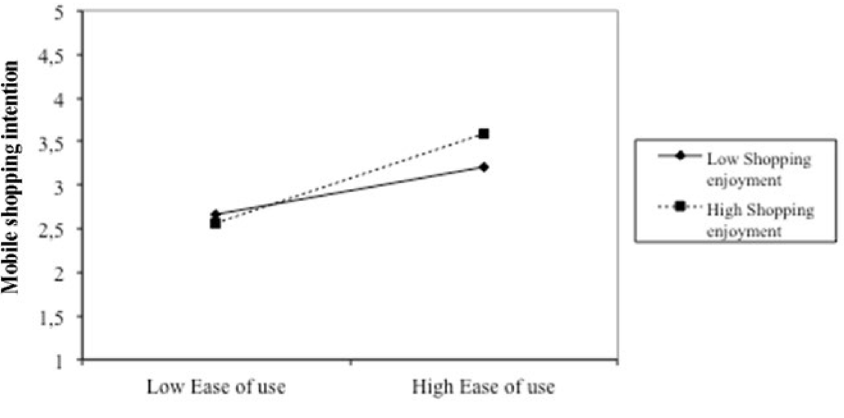
Figure 3. Relationship between ease of use